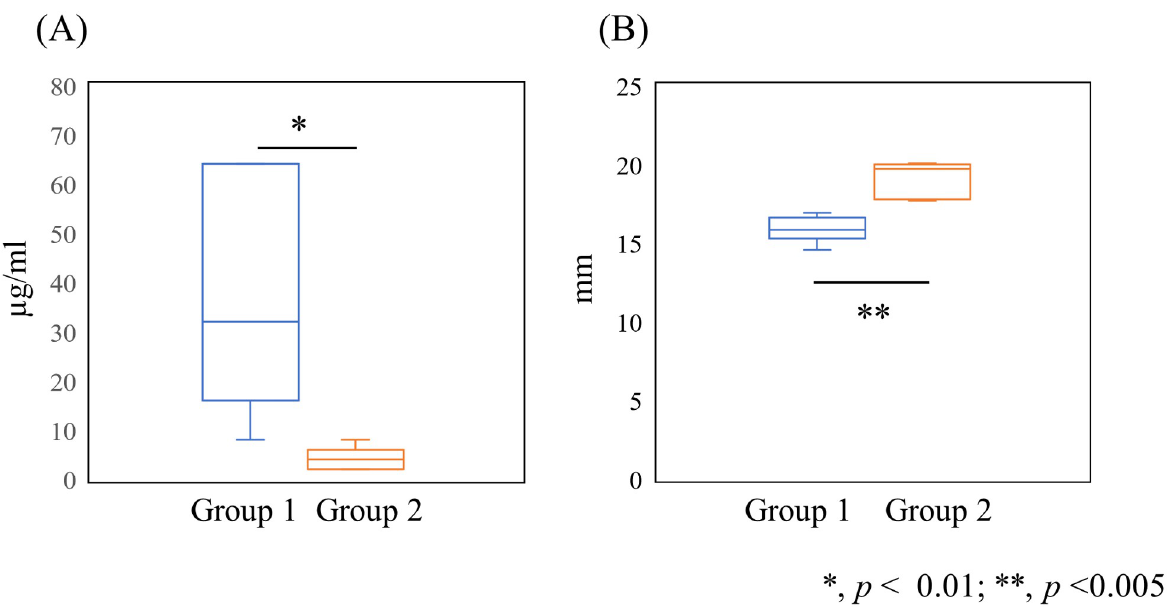
Fig 2. Comparison of susceptibility to nisin A in Groups 1 and 2. Susceptibility to nisin A between Group1 and Group 2 was compared by (A) MIC method and (B) the direct assay.